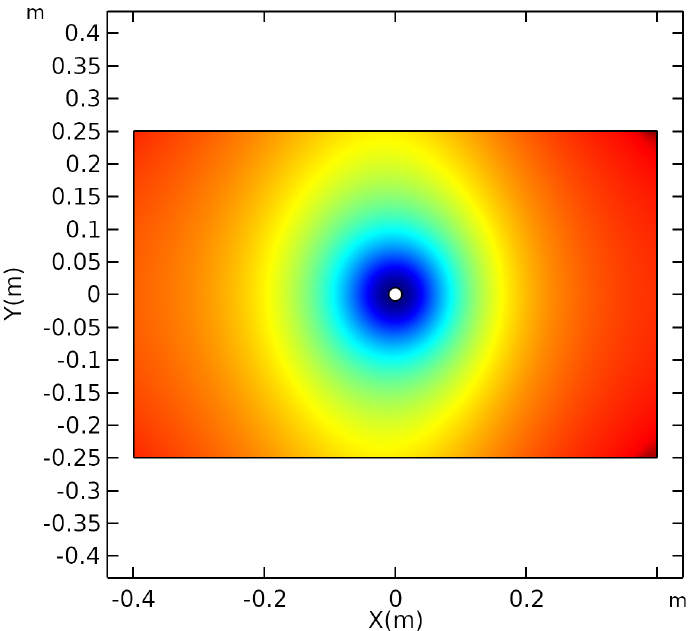
Figure 9. Simulation result of the space charge density under 15 m/s wind